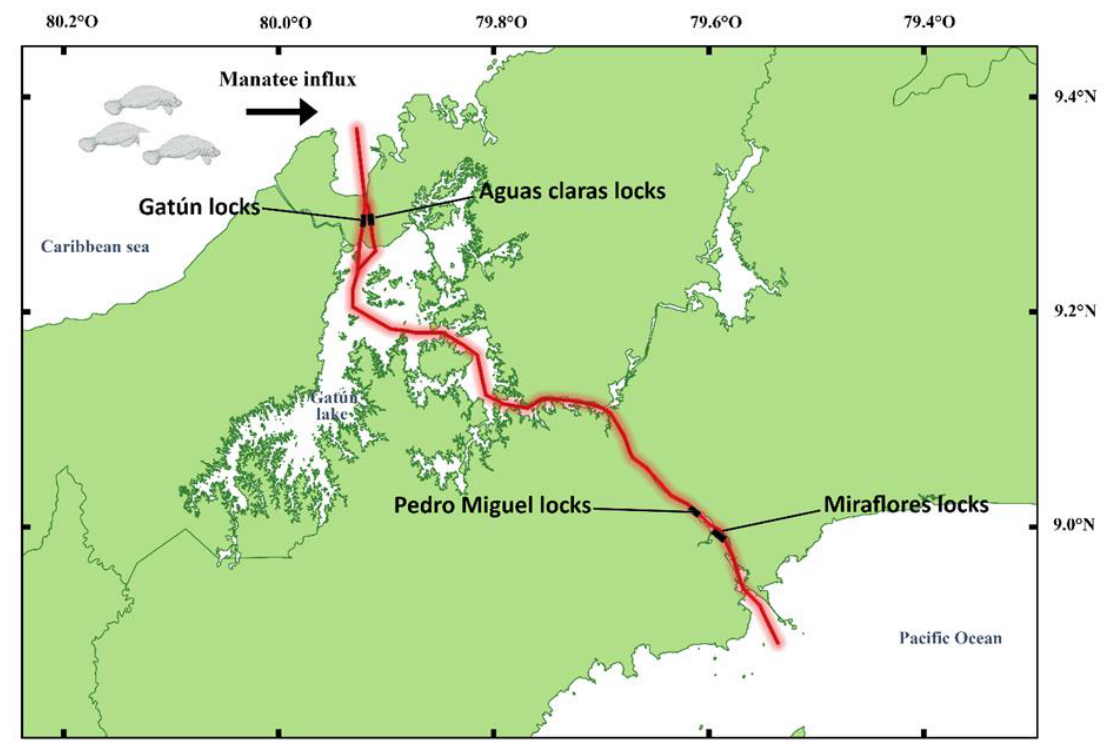
Figure 2. Image of lake Gatun highlighting the manatee influx from the Caribbean Sea into Lake Gatun through the Panama Canal locks. The red line indicates the navigation route for ships traversing the Panama Canal.